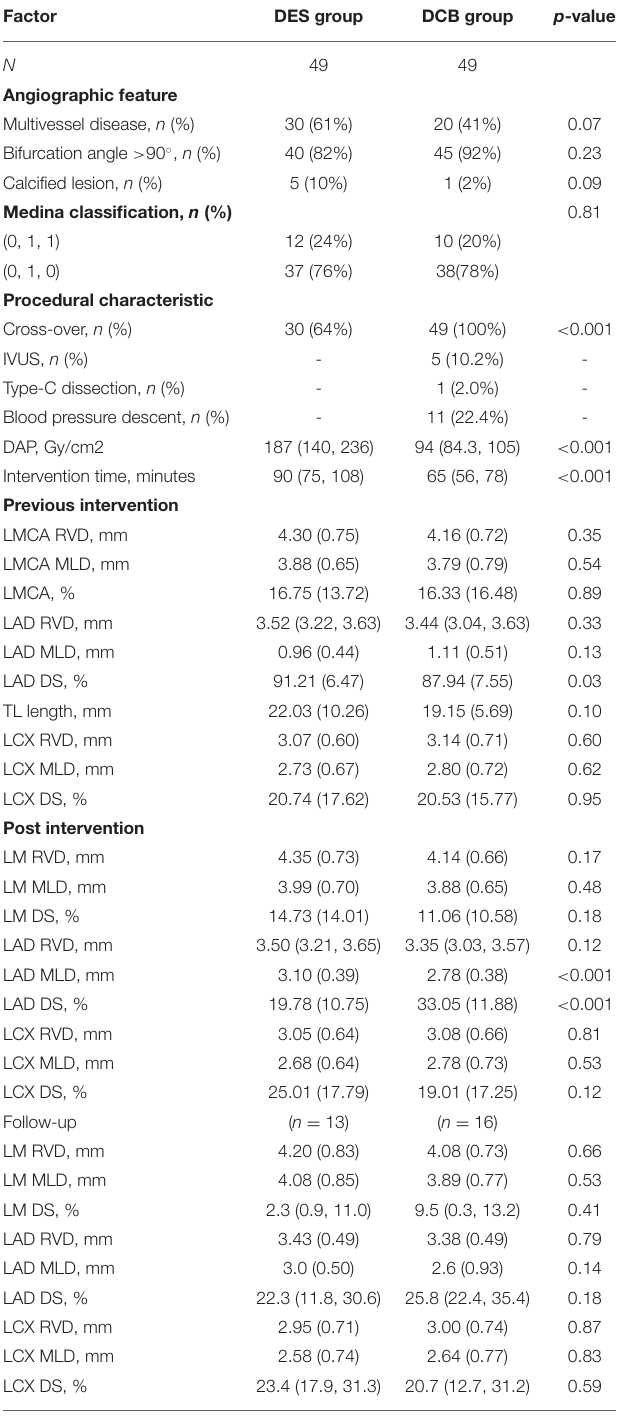
TABLE 2 | The angiographic and procedural characteristic of quantitative coronary angiography analysis. Factor DES group DCB group p -value 49